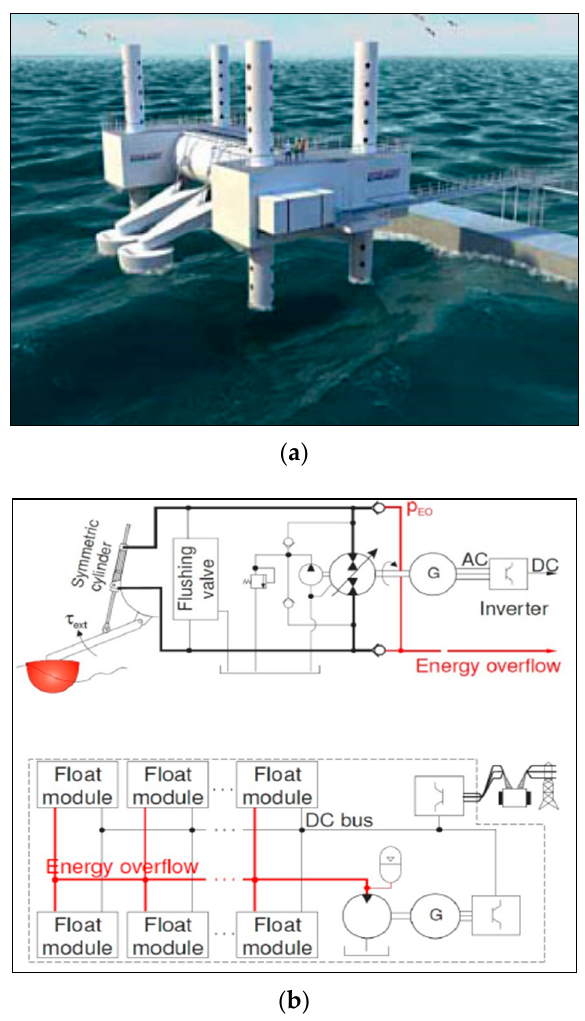
Figure 5. Wavestar system [26]. ( a ) System layout simulation near a jetty. ( b ) General scheme.